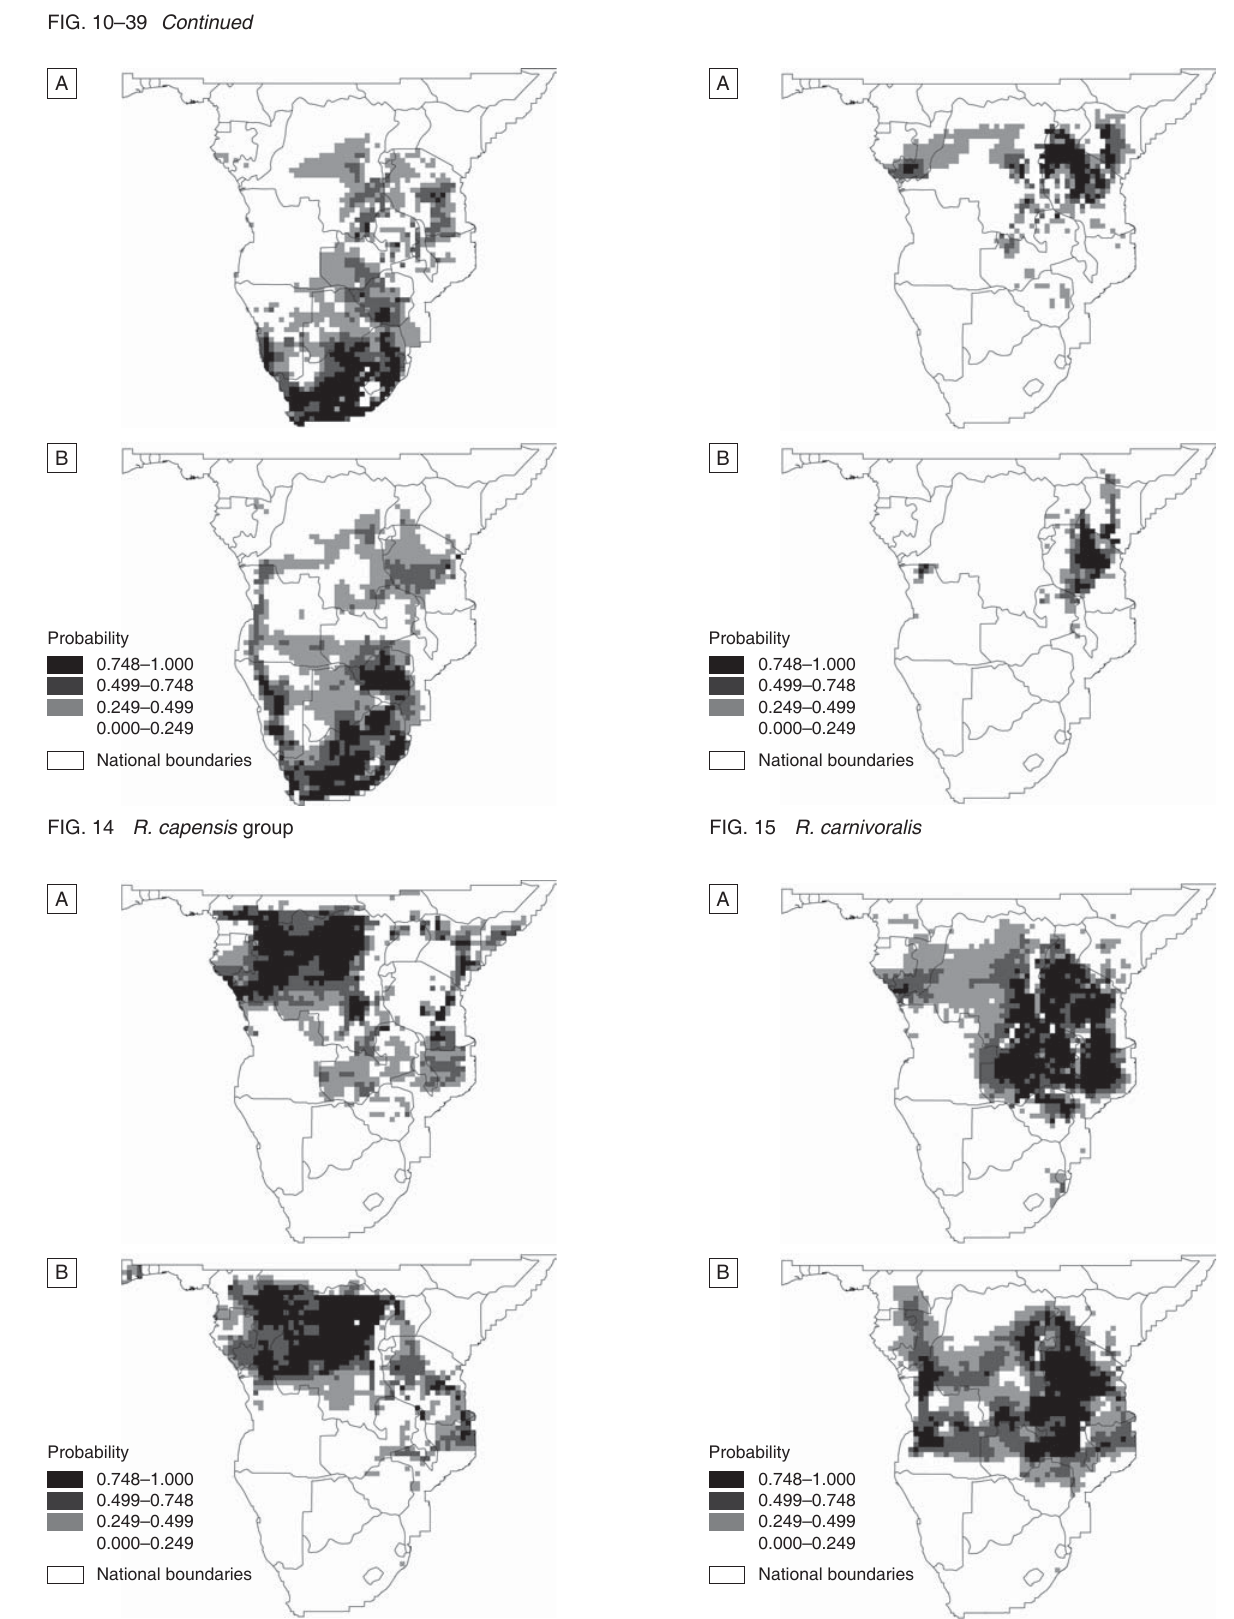
FIG. 16 R. complanatus FIG. 17 R.